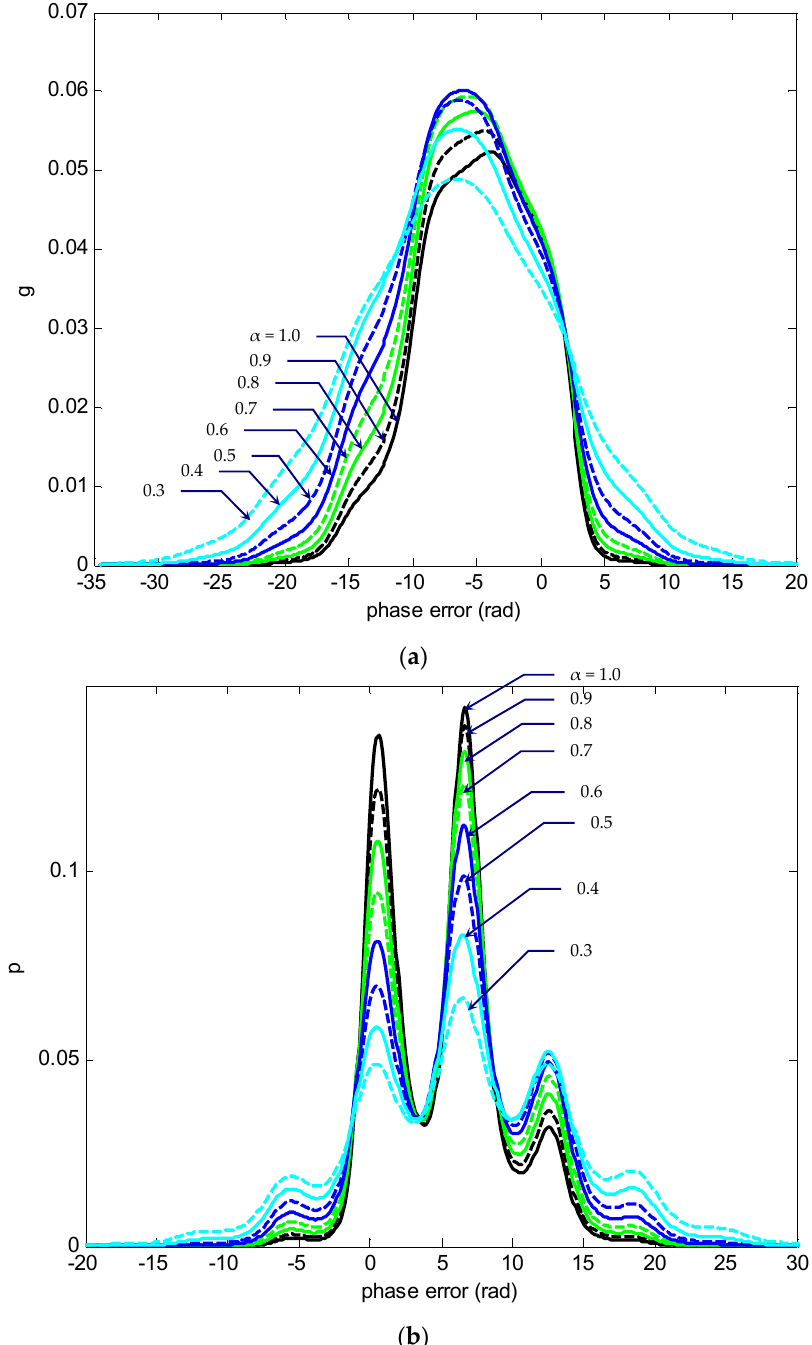
Figure 11. Nonmodulo-2 π phase-error ( a ) density function g ( ϕ , τ ) and ( b ) PDF p ( φ , τ ) , at τ = 10 for various SNR values ( γ = sin ( π /4 ) ).